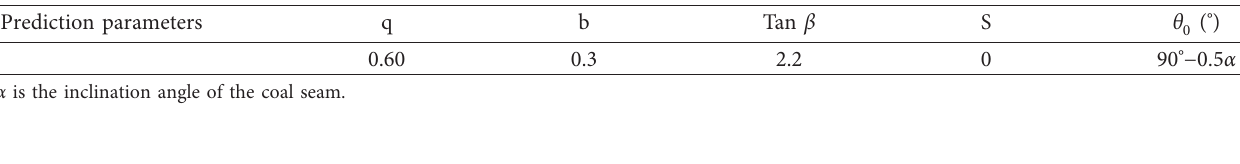
Table 4: Subsidence prediction parameters of backfilling mining.